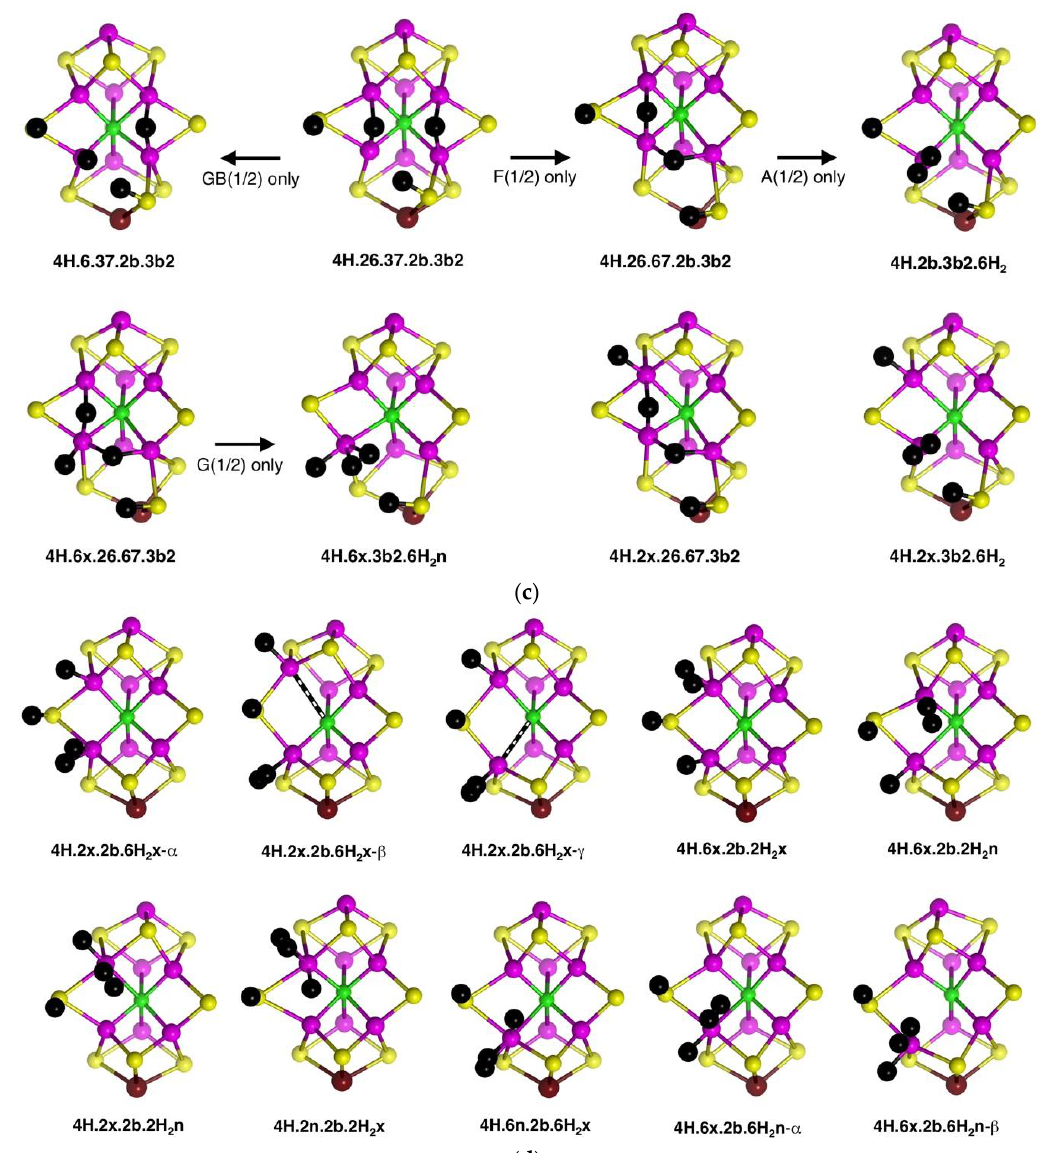
Figure 9. Optimised structures and transformations for FeMo-co ligated by four H atoms or 2H + H 2 . Fe–S distances <2.5 Å are drawn as bonds, Fe–S, and Fe–C c distances in the range of 2.5 to 3 Å are marked with a black/white striped connector, and non-bonds are greater than 3 Å . The α, β, γ suffixes distinguish C c –Fe distance isomers. ( a ) Eight structures containing H atoms on Fe2, S2B, Fe6 and S3B, followed by six structures without Fe2H, followed by three structures without S3BH. ( b ) Structures with two Fe–H–Fe bridges. ( c ) Structural transformations dependent on electronic state. ( d ) More structure containing FeH 2 .